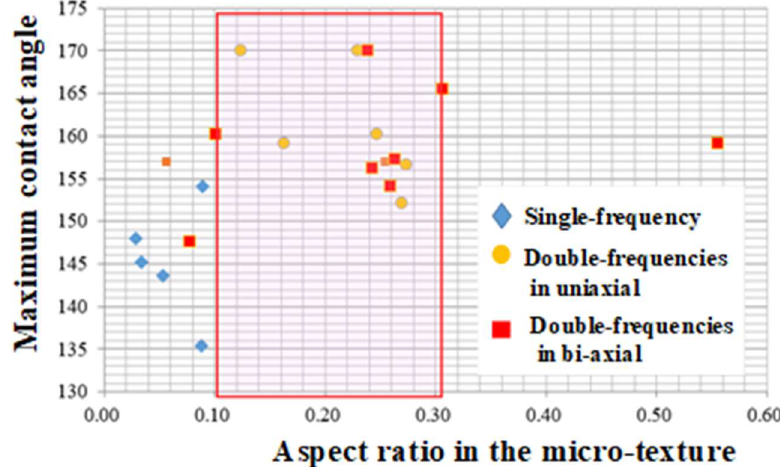
Figure 5. Effect of the aspect ratio on the measured static contact angle for various micro-textures. The red-meshed area indicates the high-lighted zone to yield super-hydrophobic surfaces in all.